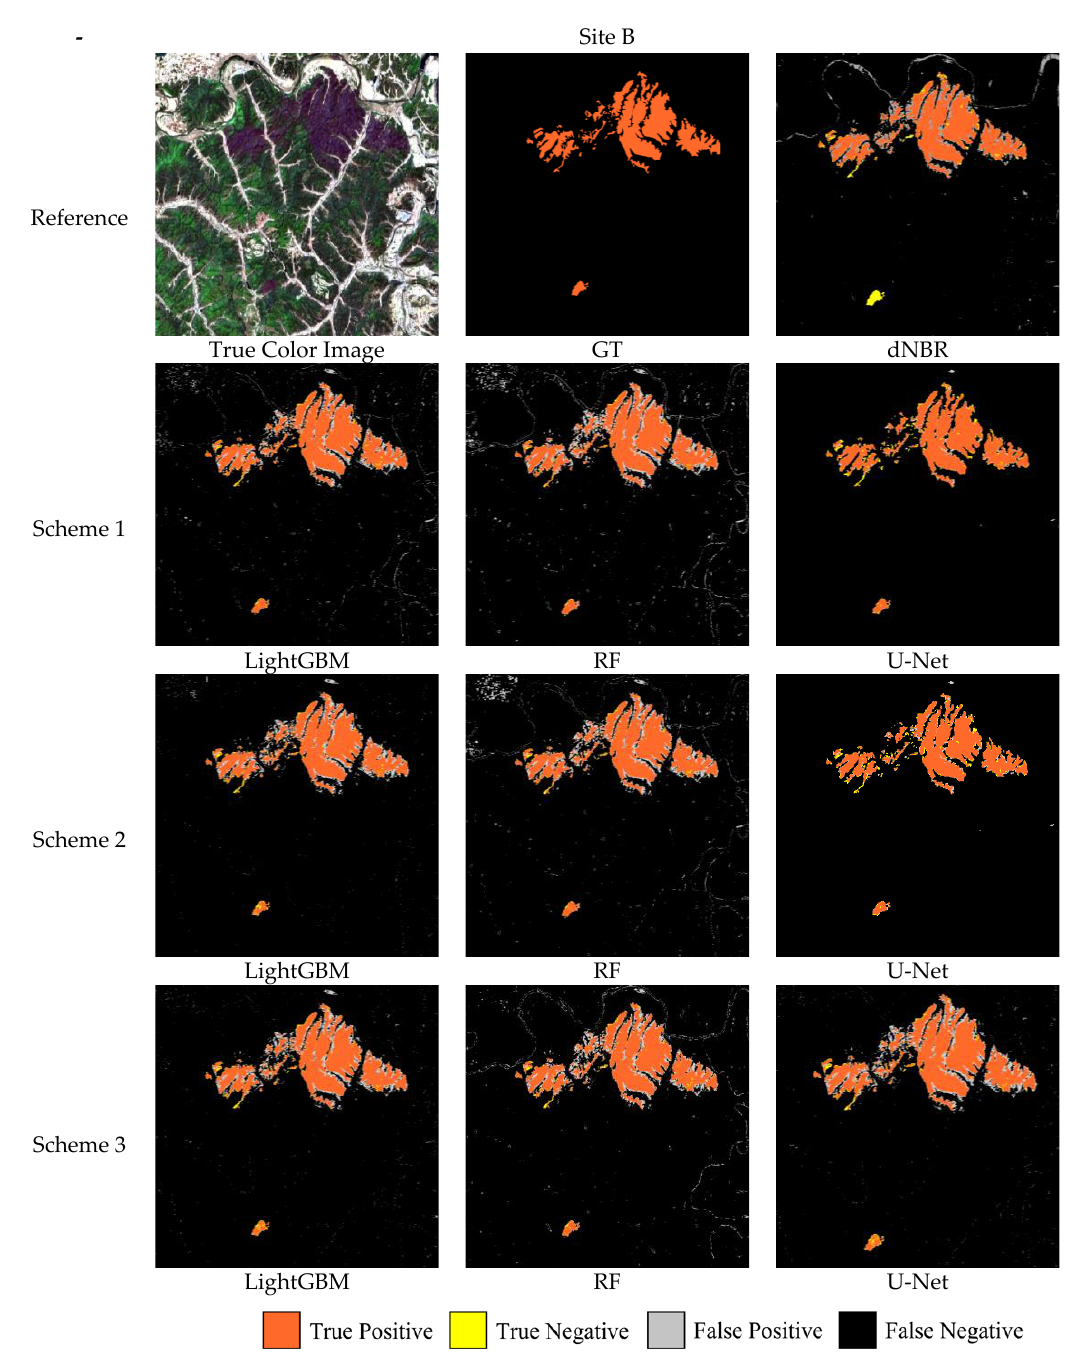
Figure 8. Visualization of burned area detection errors in Site A. The U-Net obtained robust modeling performance in all Schemes. Although misclas- sified pixels were detected, most of the pixels were identified close to the burned area’s boundary. This is because the degree of damage weakens toward the boundary [48]. The ensemble learning-based machine learning models generally exhibits a strong sensitivity to the properties of the training data and weak performance in noise [49]. In contrast, the U-Net model is more resilient to noise and less sensitive to the properties of the training data than the ensemble-based machine learning models [50–52]. It is therefore appropriate to use the U-Net to identify burned areas from forest